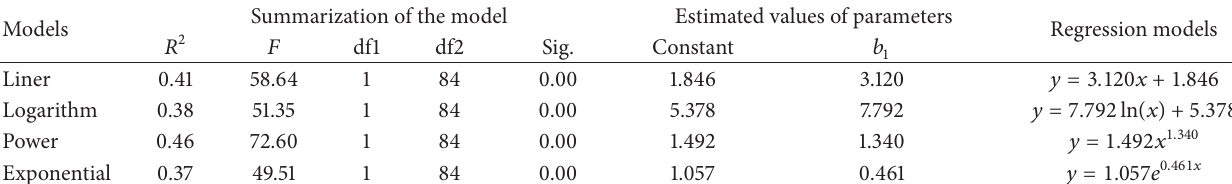
Table 4: Summarization of regression models and estimated values of parameters.